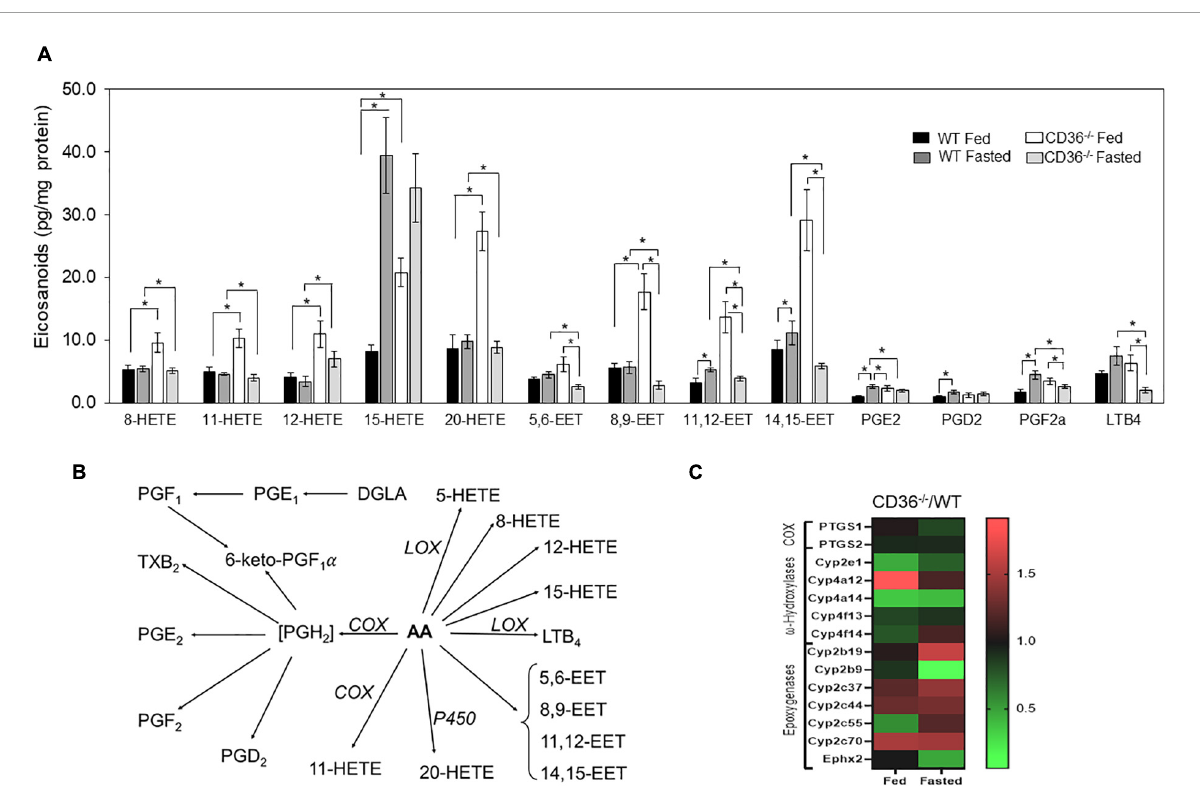
FIGURE3 CD36 deficiency affects cardiac eicosanoid content. (A) Eicosanoid content in fed or fasted WT and CD36 − / − heart ( n = 5/group). Results are reported as pg/mg of protein. (B) Gene expression fold change of key enzymes regulating eicosanoid production. Data are means ± SE with n representing the number of mice per group, * p < 0.05. (C) The scheme represents downstream metabolites of arachidonic acid (AA) via cyclooxygenase (COX), lipoxygenase (LOX), or cytochrome (P450) pathways.